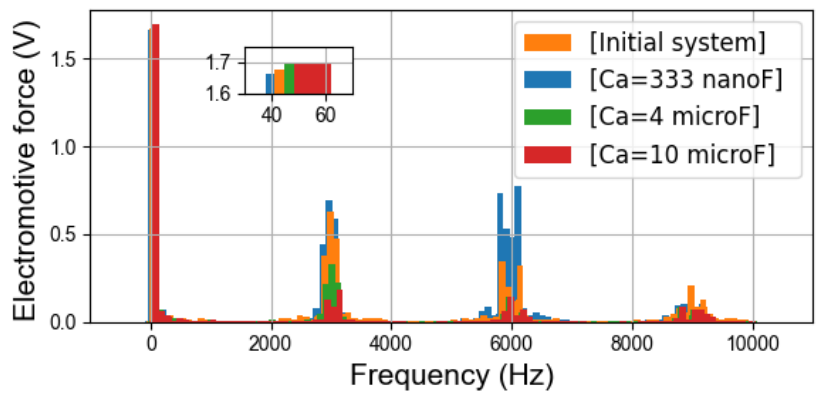
Figure 11. Electromotive force (one turn) spectra with f swi = 3